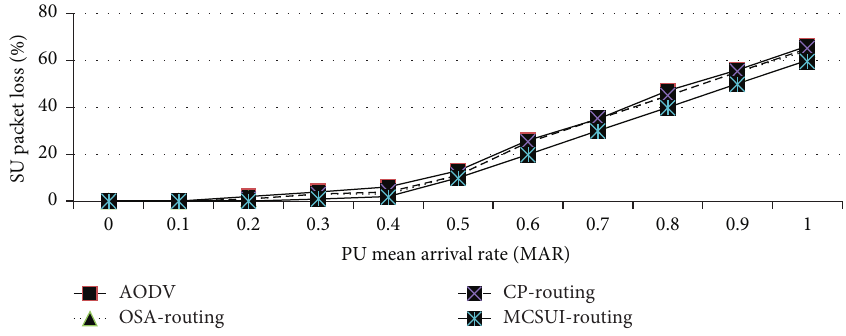
Figure 15: Packet loss of SU at PU’s sd of MAR as 0.0 (user/ms).